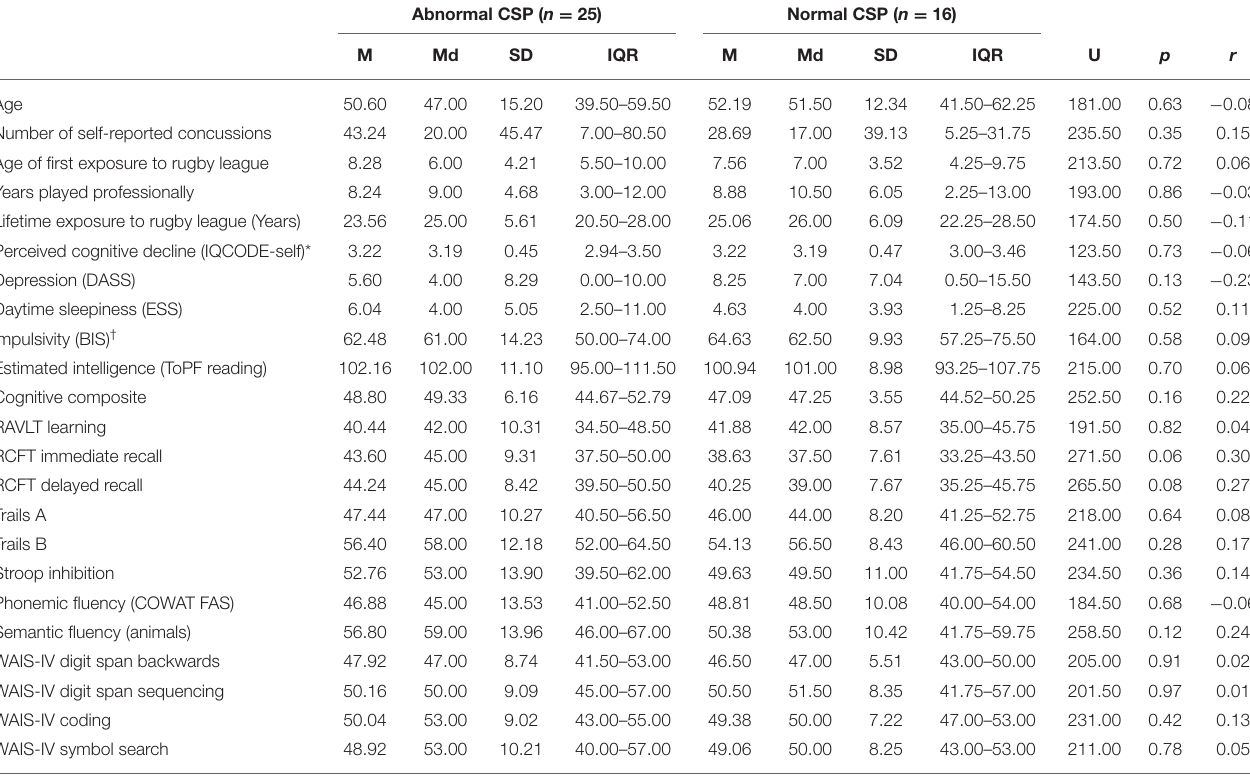
TABLE 2 | Clinical measures and concussion exposure variables in retired Rugby League players only ( n = 41). Abnormal CSP ( n =